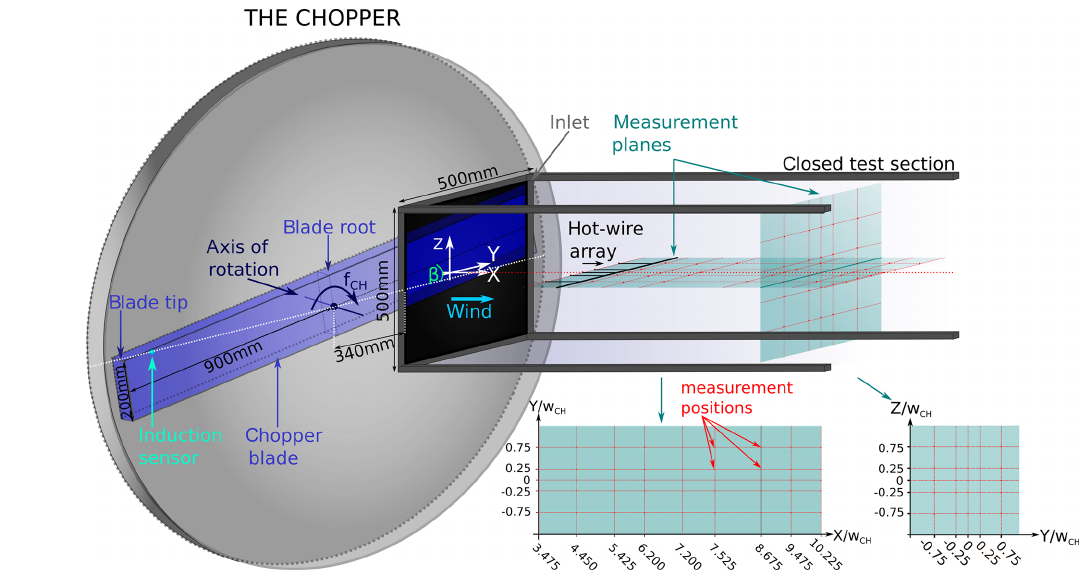
Figure 1. Experimental setup: the rotating chopper blade (blue) cuts through the inlet of the wind tunnel test section, thus generating a flow disturbance. An induction sensor returns a signal when the chopper blade crosses the horizontal centerline of the test section inlet. Measurements were carried out using an array of five hot-wire probes at the positions marked with red dots within the turquoise measurement